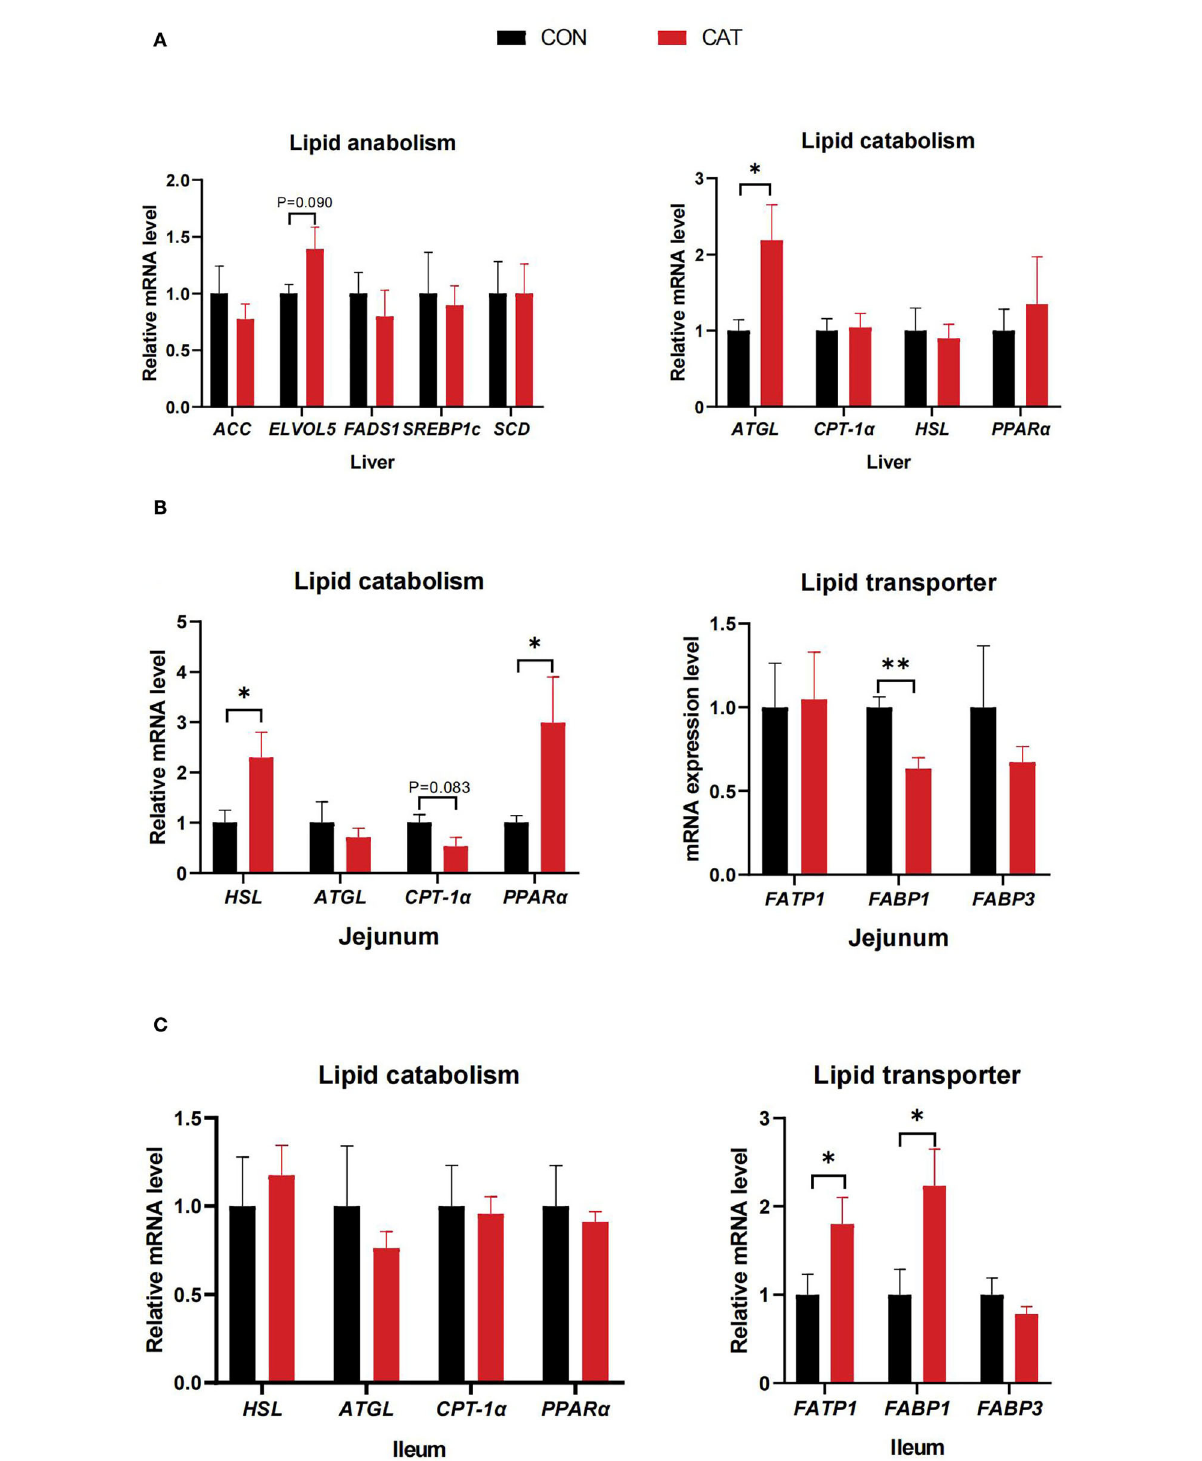
FIGURE5 (A–C) The mRNA expression of genes related to lipid metabolism of suckling piglets. Values are presented as mean ± SEM; n = 6, * and **indicate a significant difference at P < 0.05 and P < 0.01, respectively. ACC, acetyl-CoA carboxylase; ELOVL5, fatty acid elongase 5; FADS1, fatty acid desaturase 1; SREBP1c, sterol regulatory element-binding protein 1c; SCD, stearoyl coenzyme A desaturase; ATGL, adipose triglyceride lipase; CPT-1 α , carnitine palmitoyltransferase 1 α ; HSL, hormone-sensitive lipase; PPAR α , peroxisome proliferator-activated receptor α ; FATP1, fatty acid transport protein 1; FABP1, fatty acid-binding protein 1; FABP3, fatty acid-binding protein